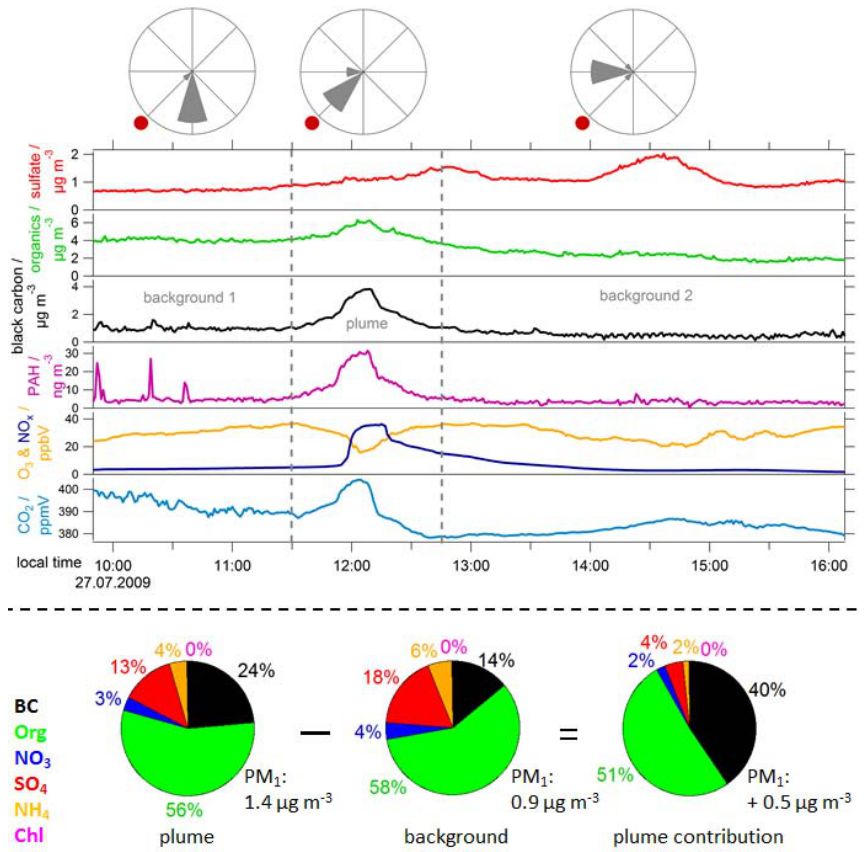
Fig. 6. CO 2 (light blue), O 3 (yellow) and NO x (dark blue) mixing ratios as well as PAH (purple), black carbon (black), particulate organics (green) and sulfate (red) mass concentrations measured during a stationary measurement on 27 July 2009 by MoLa. The measurement location (centre of windrose plots) was in the North-East of Paris (red dot in windrose plots) situated about 30km from the city border. The wind was shifting from South to West during the measurement as indicated by the wind rose plots. The grey vertical dashed lines frame the time period when the Paris emission plume was sampled. The time resolution of the data is 1min. However, internal averaging settings of the NO x module caused longer averaging times (several minutes, slightly varying with concentration changes) during this stationary measurement for this instrument. Additionally, the average PM 1 aerosol mass concentrations and compositions for plume and background air masses are provided in the lower part of this figure. The total PM 1 mass concentration was calculated as the sum of BC (MAAP instrument), Org, NO 3 , SO 4 , NH 4 and Chl (AMS instrument) concentrations. The subtraction of the average background concentration from the average plume concentration gives the plume contribution to total PM 1